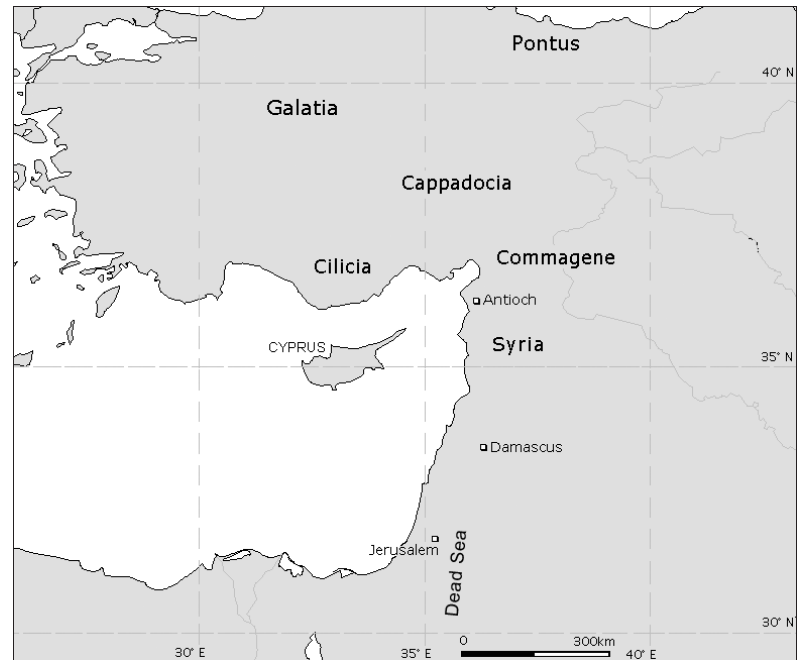
Fig. 4. Orientation map for the 64 B.C.